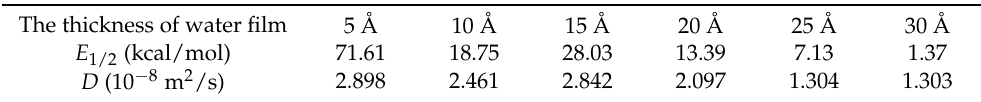
Table 3. Interaction energy ( E 1/2 ) and self-diffusion coefficients ( D ) of naphthalene on kaolinite/ water